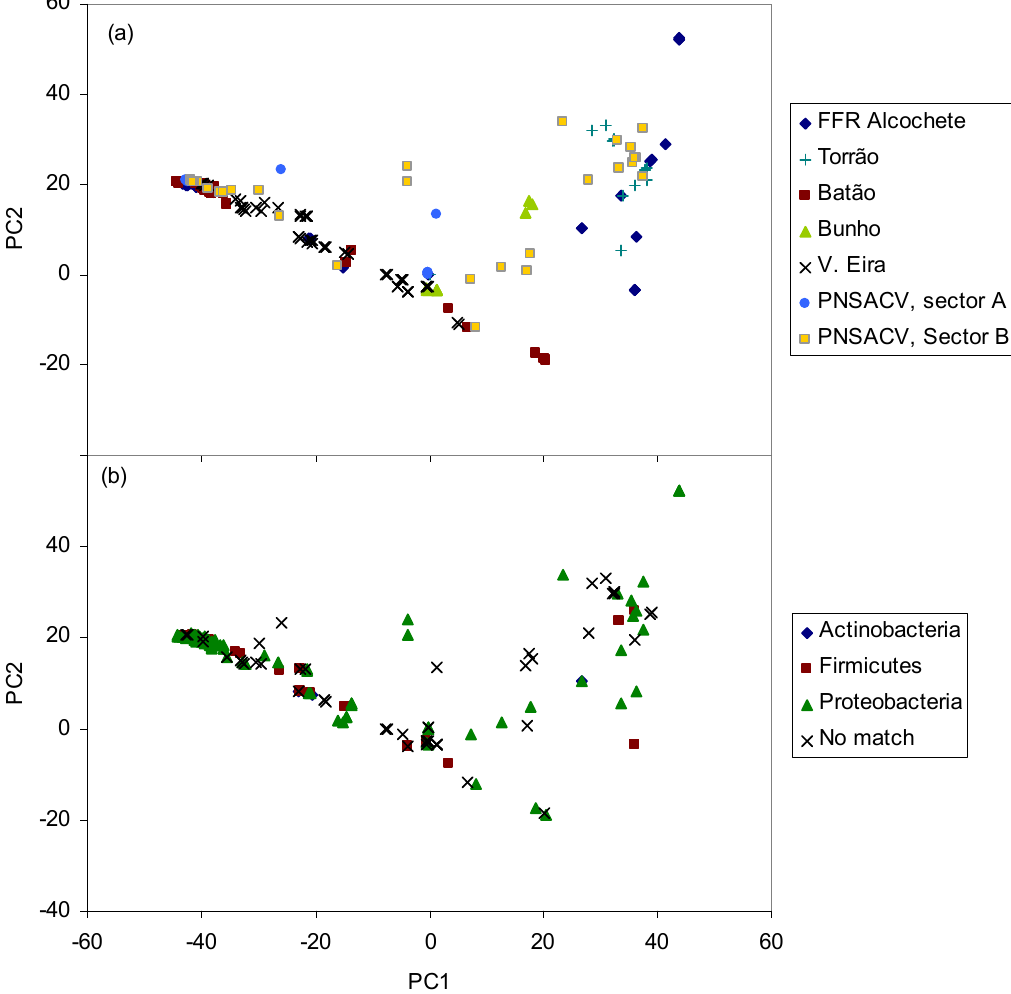
Figure 2. Scores of the sampled ponds (upper panel) and phyla of bacterial identified in the ponds (lower panel) along the first two axes resulting from PCA of fatty acid composition of bacterial